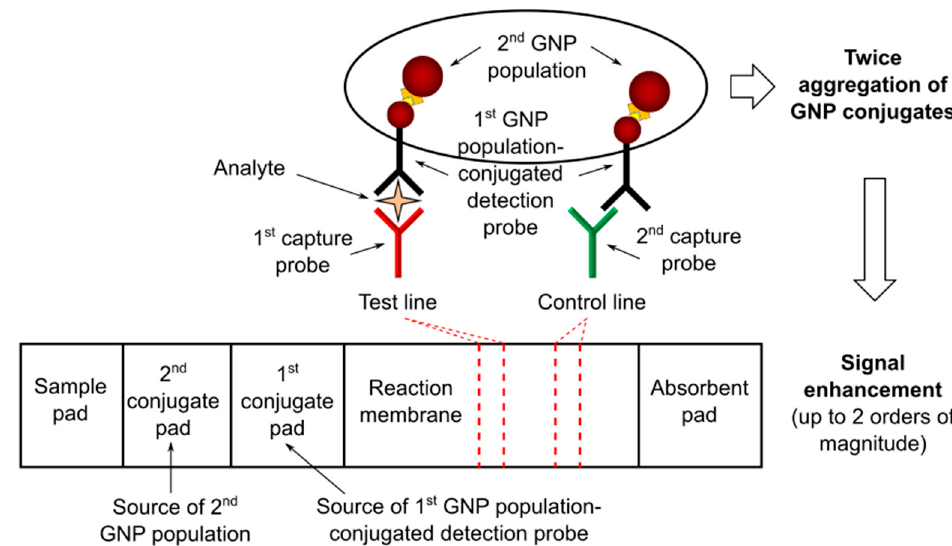
Figure 3. Schematics of dual gold signal enhancement method applied to LFTs. GNP, gold nano- particle.